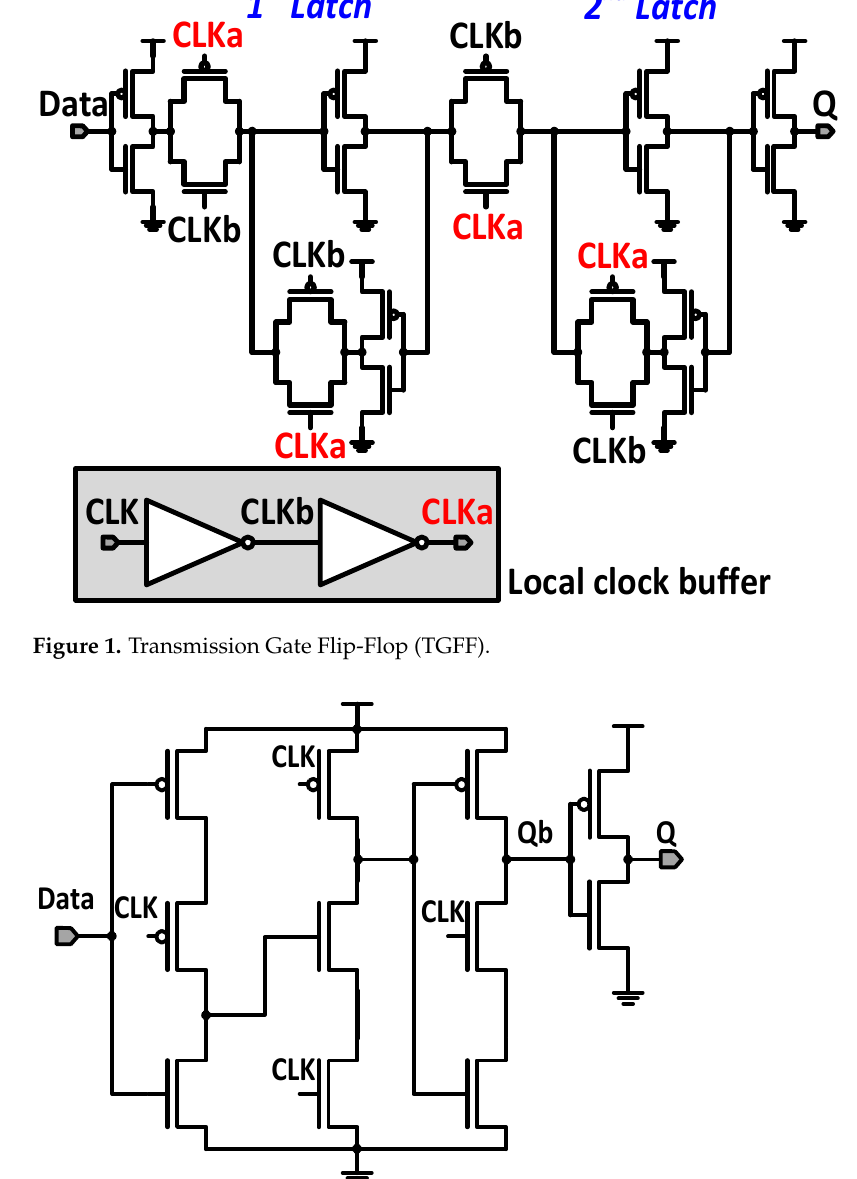
Figure 3. Static Single-phase Contention-free Flip-Flop (S 2 CFF). DNCS CS Figure 4. Change-Sensing Flip-Flop (CSFF).